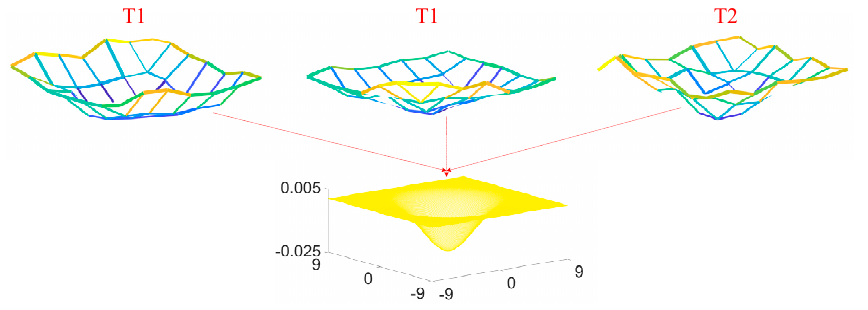
Figure 3. IGD kernel function.